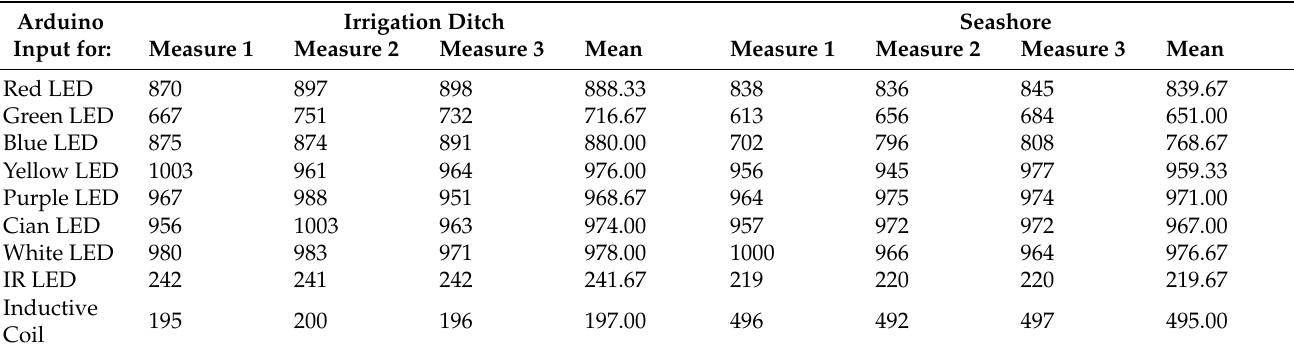
Table 4. Summary of data gathered in real tests.